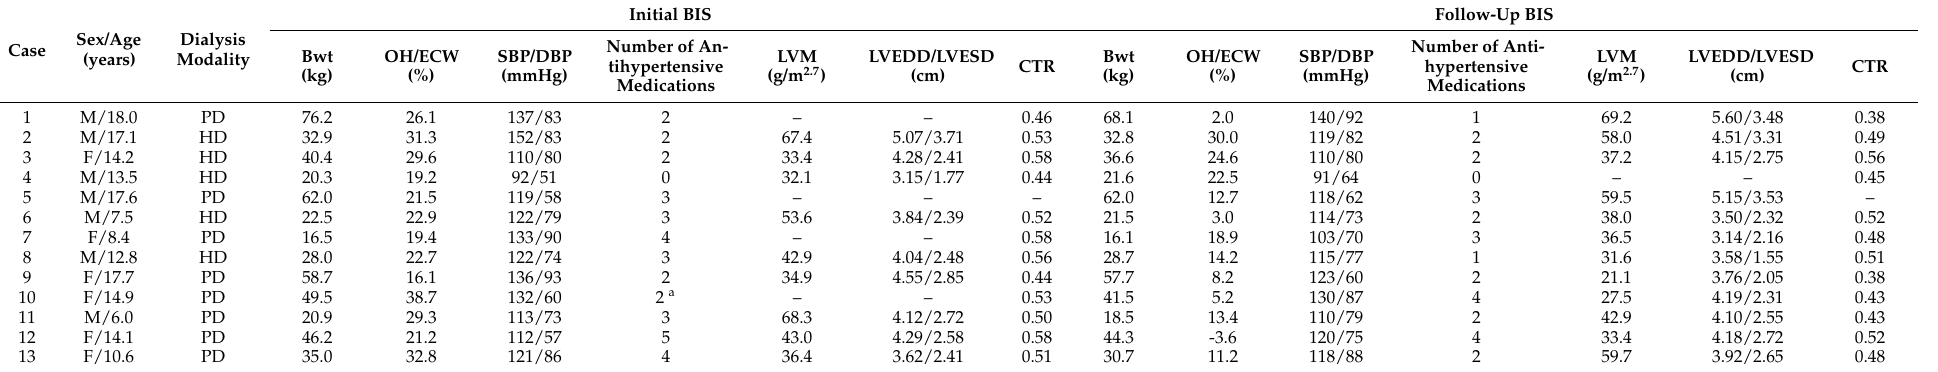
Table 4. The change in hydration status and cardiovascular indicators among patients with fluid